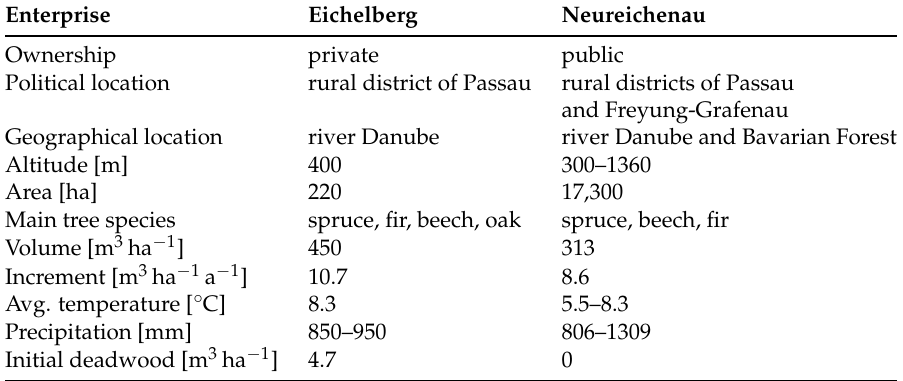
Table 2. Main characteristics of the investigated forest enterprises located in the east of Lower Bavaria, Bavaria, Germany. Volume and increment are values without bark